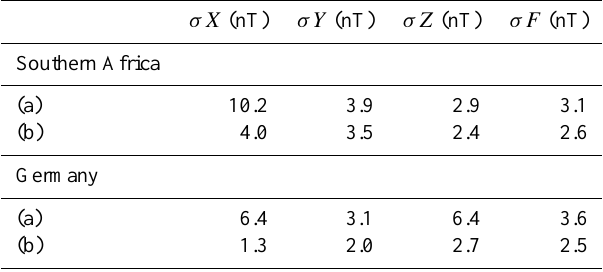
Table 1. Average standard deviation σ in lithospheric anomaly es- timation at repeat station locations.